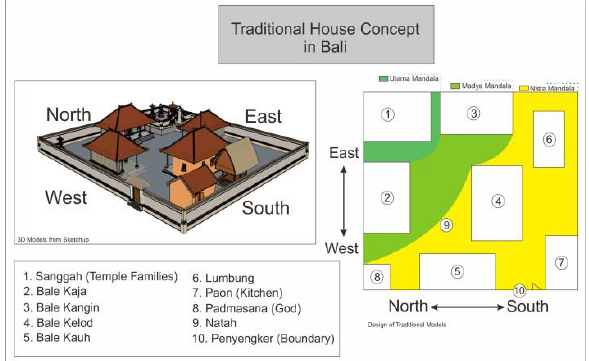
Figure 4. Traditional Building Concept